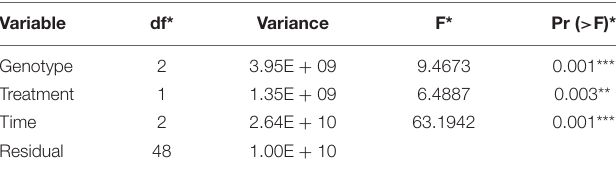
TABLE 1 | Redundancy analysis results using a linear covariate model and analysis of variance. Variable df* Variance Pr ( >